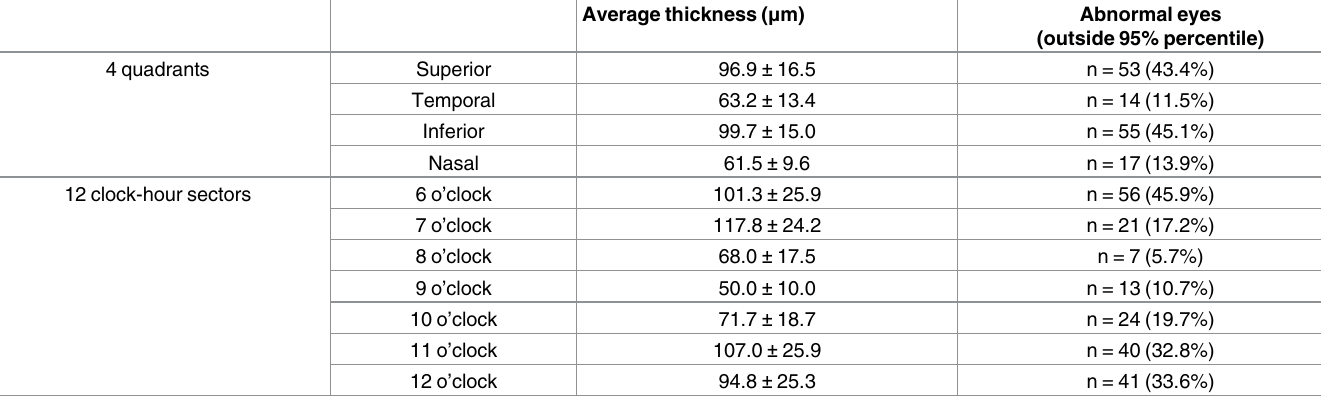
Table 2. Abnormality of circumpapillary retinal nerve fiber layer thickness at baseline in preperimetric glaucoma eyes.